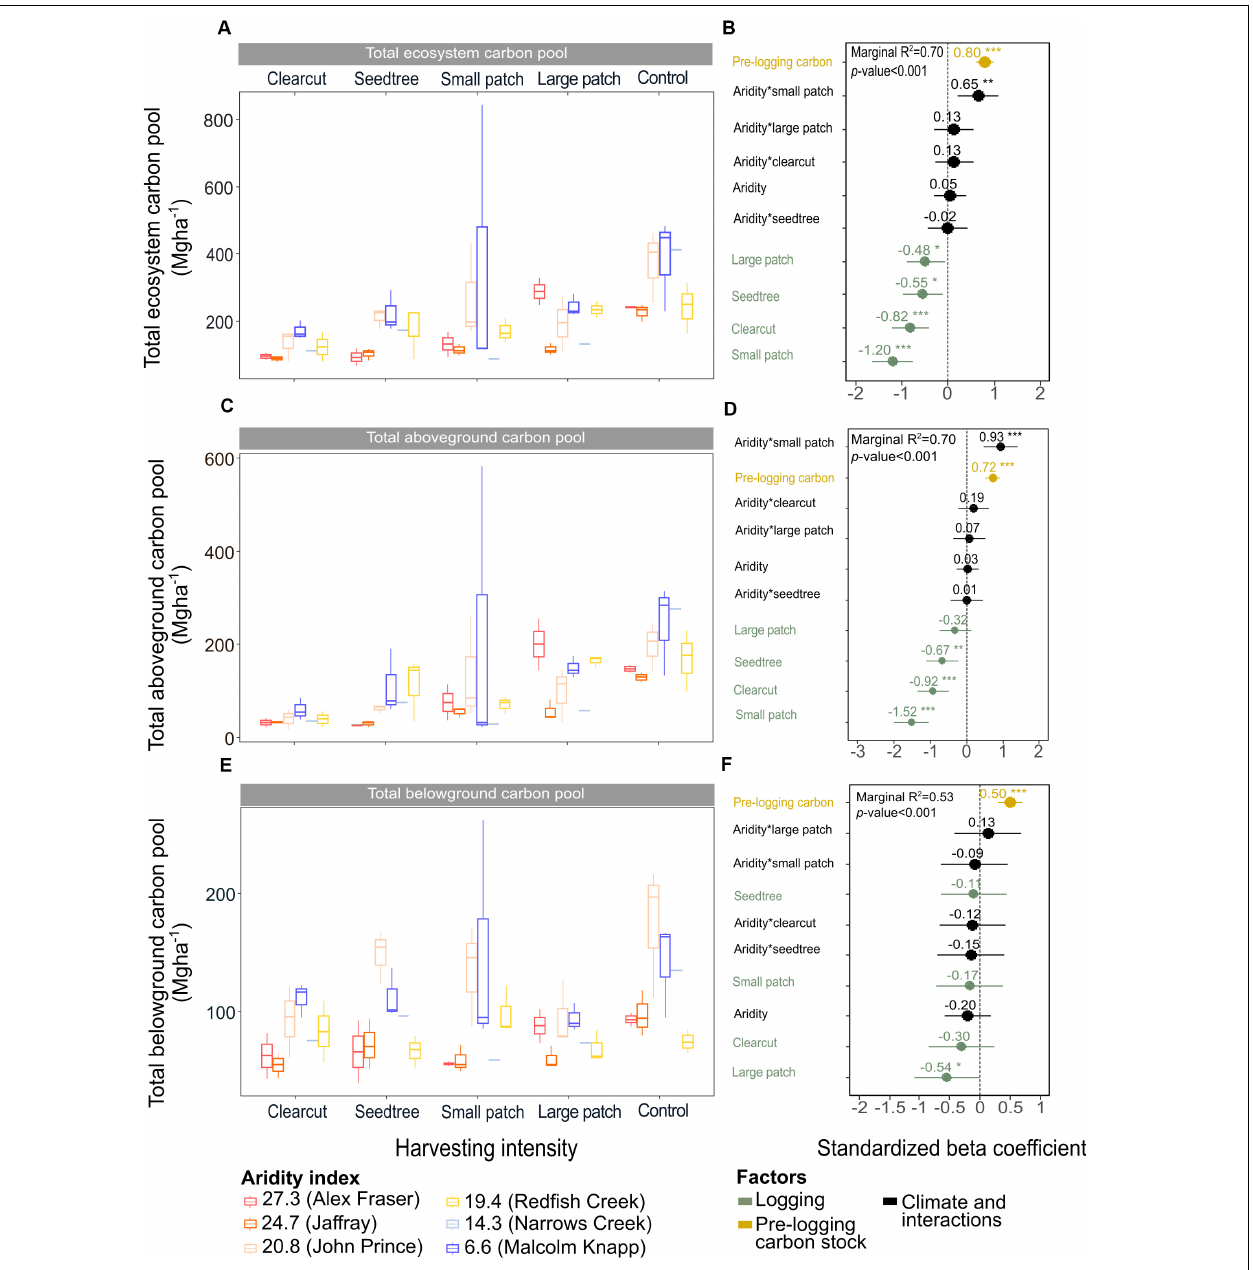
FIGURE 3 | Effects of harvesting intensity and climatic aridity on the ecosystem, aboveground and belowground carbon pools of mixed Douglas-fir forests ( n = 3 for all locations, except Narrows Creek where n = 1 and Alex Fraser where n = 2). (A,C,E) present the relationship between harvesting intensity and carbon stocks. (B,D,F) present standardized beta coefficients of the linear mixed-effect models. Beta coefficients illustrate the effect of factors on the total, aboveground and belowground carbon pools in terms of their standardized effect sizes. Circles indicate average estimates and lines indicate 95% confidence intervals. The aridity index was calculated as [mean annual temperature + 10]/[mean annual precipitation/1000]. Pre-harvest carbon stocks were added as covariates in the linear mixed-effect models. For harvesting intensity, each coefficient represents the difference between the uncut control and a given treatment. *** P -value < 0.001; ** P -value <